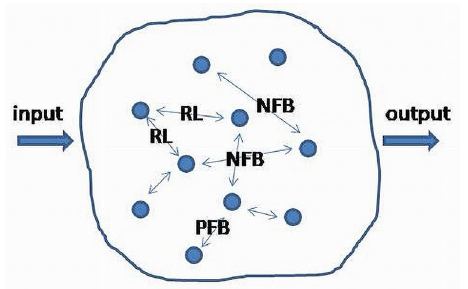
Figure 5. Feedback base regulatory patterns of a biologic system. PFB—positive feedback; NFB— negative feedback; RL—reciprocal links; (PNR). PNR are functional invariants of a biologic system on molecular, cell and organ